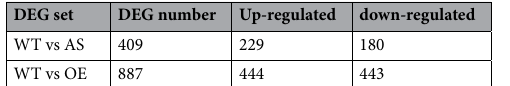
Table 4. Statistical table of number of different expression